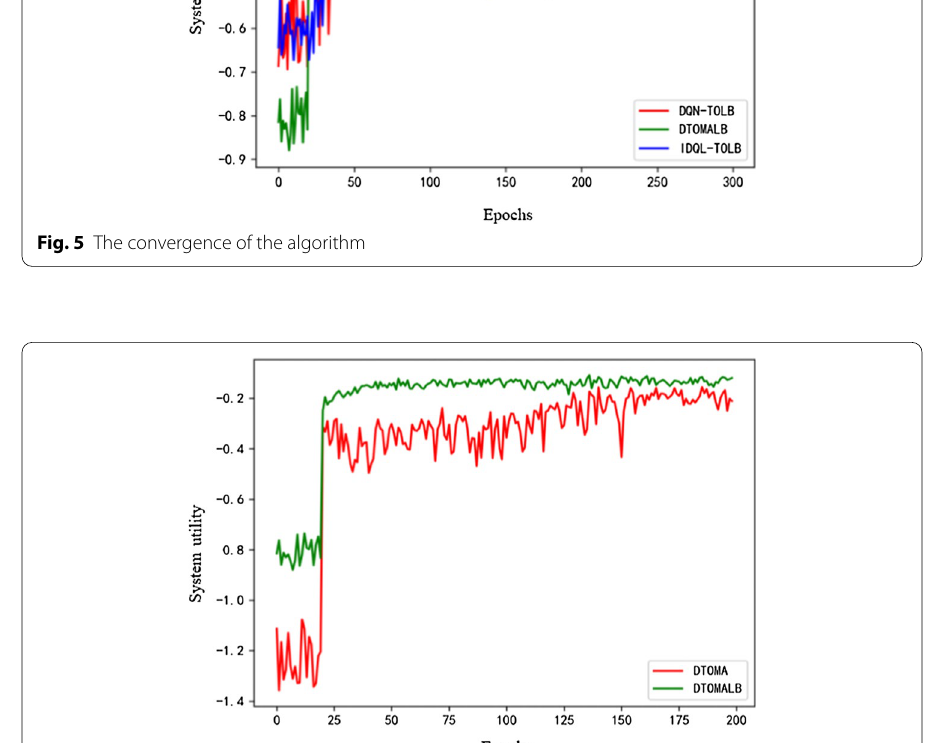
Fig. 6 Comparison of training with and without load balance